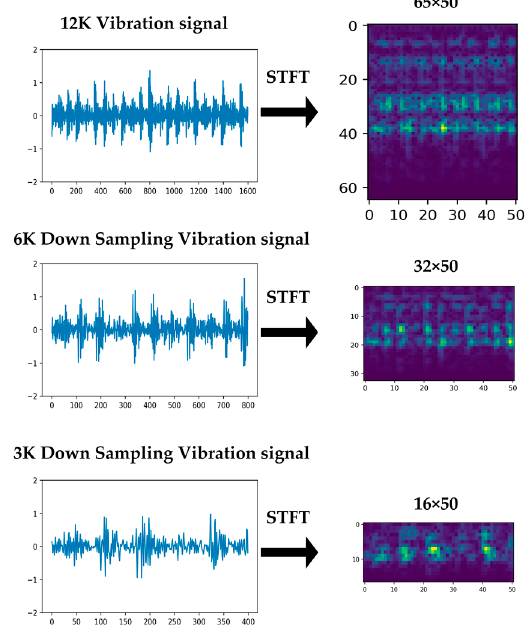
Figure 4. Downsampled vibration sensor signals and generated spectrograms.